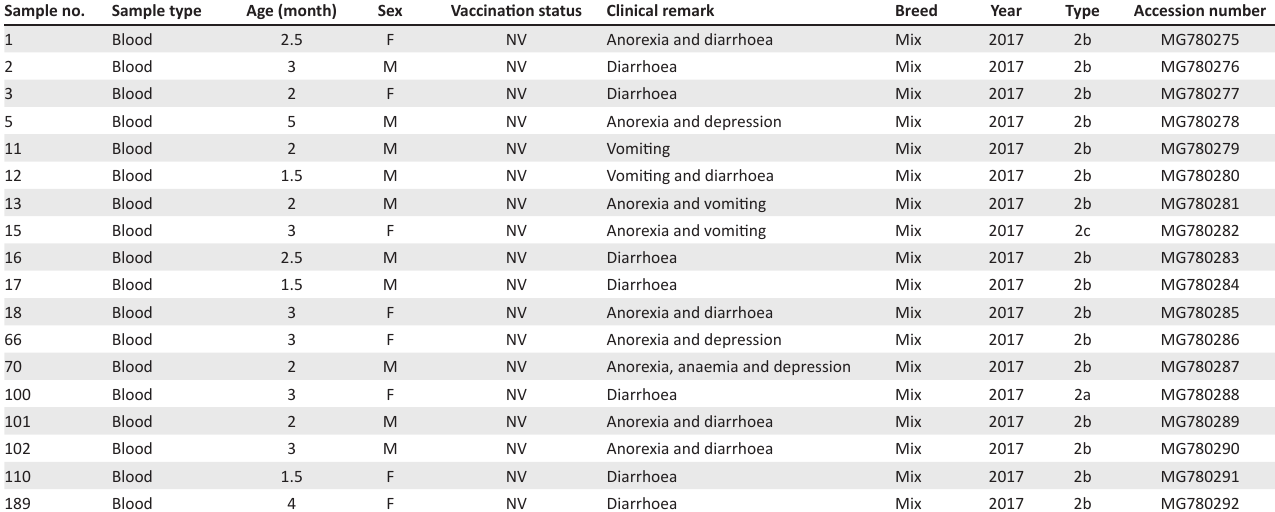
TABLE 2: Sample no, age, accession numbers and clinical sings of dogs infected with canine parvovirus. Sample no. Sample